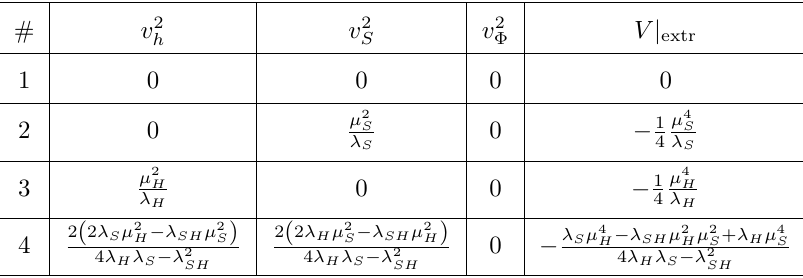
Table 2 . The table shows possible extrema with v Φ = 0 and corresponding values of the poten- tial